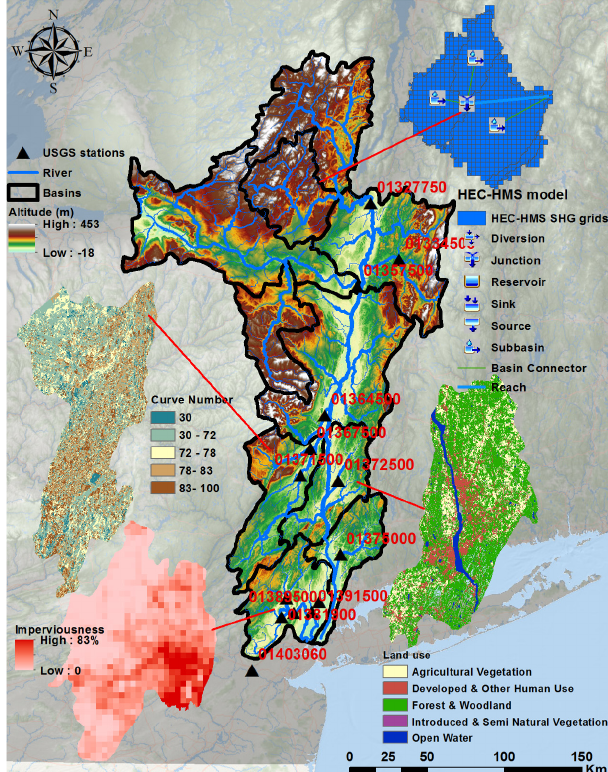
Figure 2. Map showing the Hudson River basin topography includ- ing basin divisions (thin black lines) and hydrographic network. Examples of land use, curve number and imperviousness data sets (zoomed) that were used in HEC-GeoHMS to construct the hydro- logical model are also shown. The upper right side of the figure exhibits an example of the HEC-HMS model structure and its sub- basins using standard hydrologic grids (SHG (2 ×